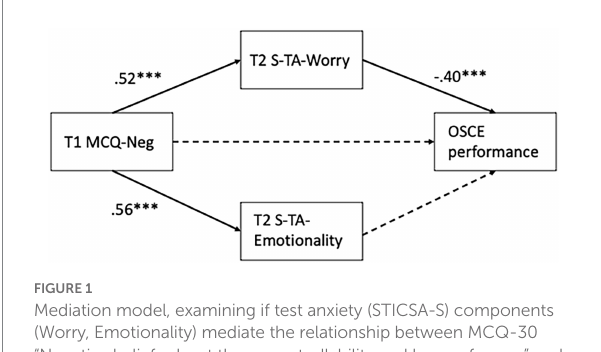
FIGURE 1 Mediation model, examining if test anxiety (STICSA-S) components (Worry, Emotionality) mediate the relationship between MCQ-30 “Negative beliefs about the uncontrollability and harm of worry” and OSCE performance, whilst controlling for gender. * = p < 0.001. T1, Time 1; T2, Time 2; MCQ, Metacognitions Questionnaire – 30; Neg, Negative beliefs about the uncontrollability and danger of worry; S, State–Trait Inventory of Cognitive and Somatic Anxiety – State; TA, Test Anxiety; OSCE, Objective Structured Clinical